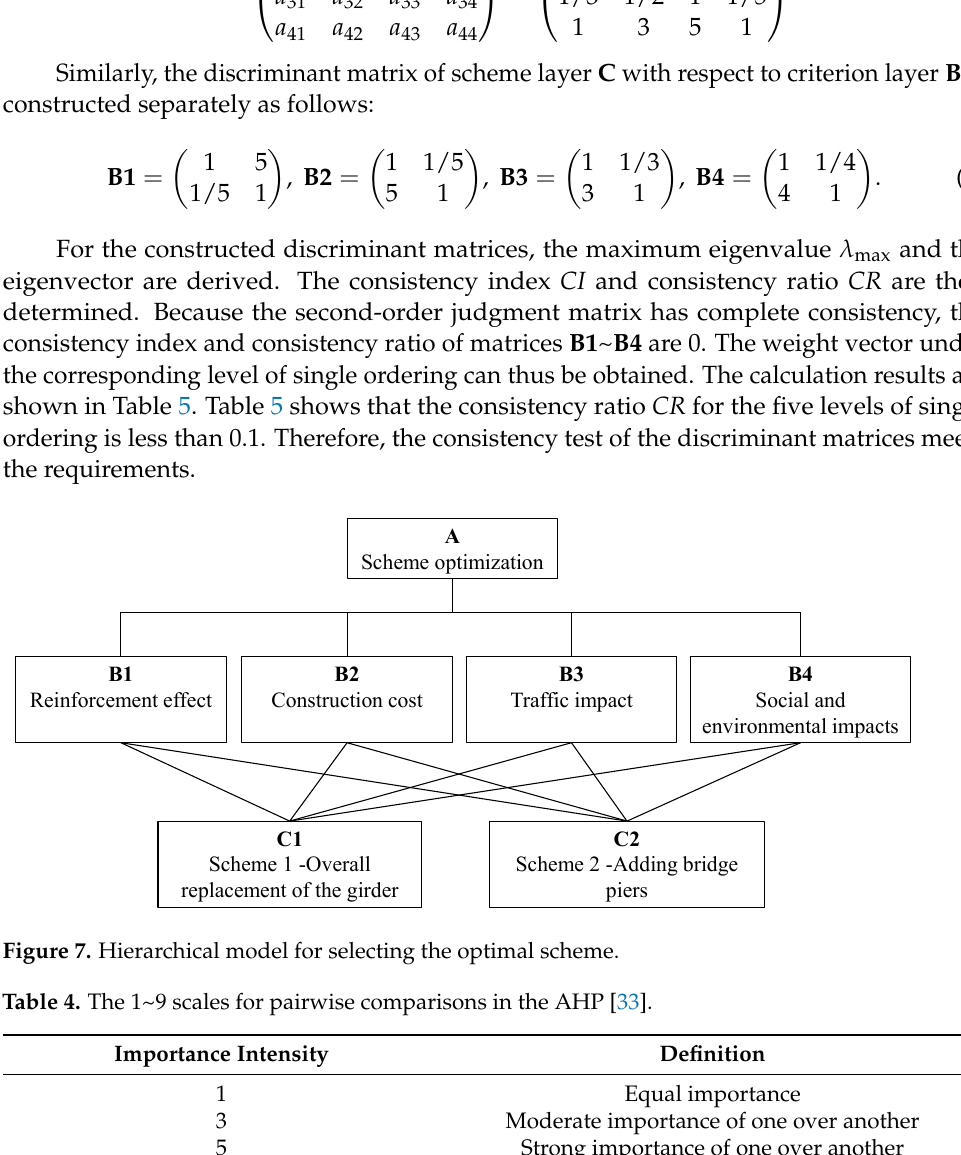
Table 4. The 1~9 scales for pairwise comparisons in the AHP [33].